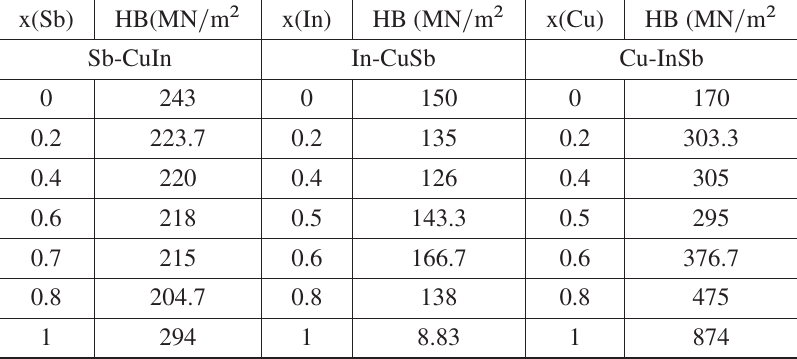
Table 3. Alloys compositions and Brinell hardness.